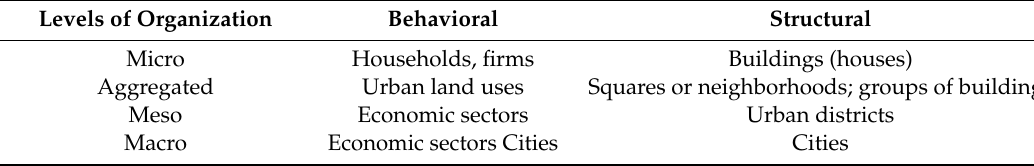
Table 1. Levels of organization of energy